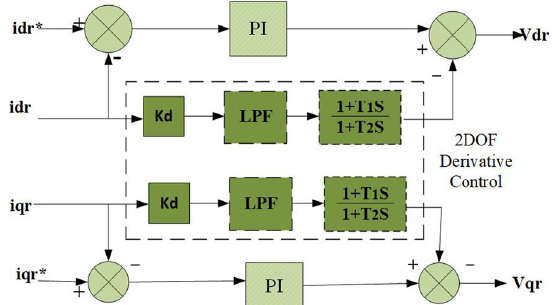
Fig. 12 2DOF added current control loop of RSC